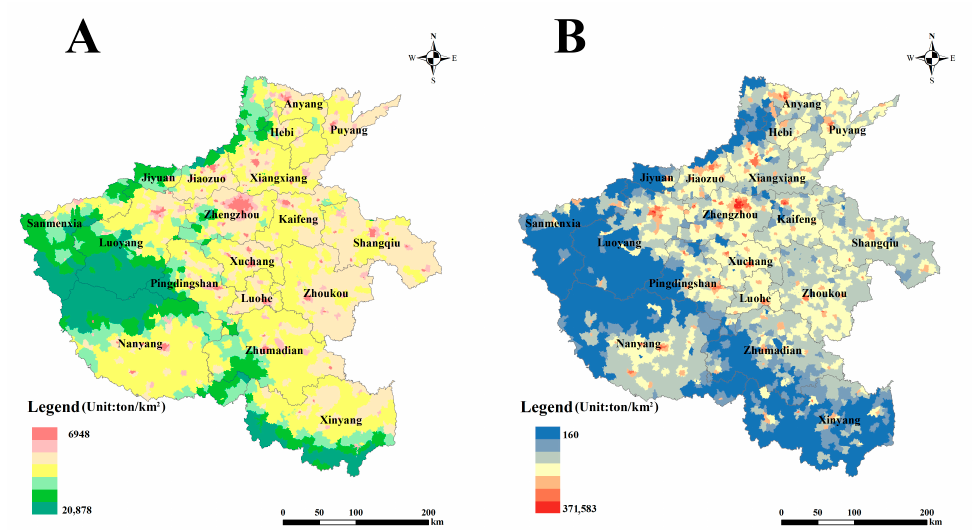
Figure 2. Spatial distribution of carbon sequestration supply and demand (( A ) and ( B ) are CS supply and demand, respectively). and demand,